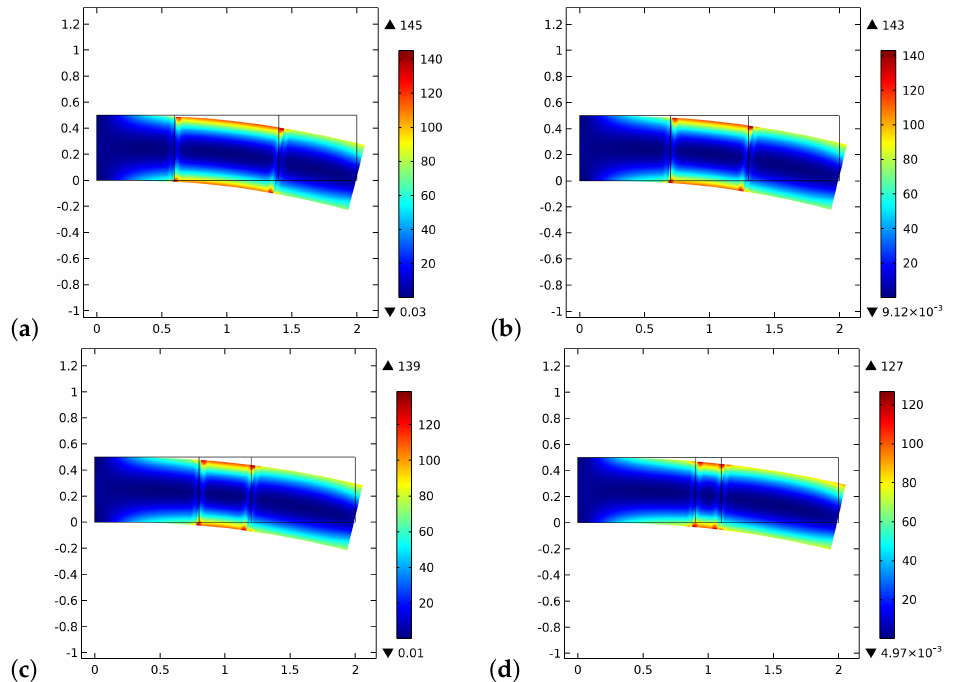
Figure 10. The distribution of the dissipated energy density at the beginning of the time of simulation for different substitute lengths of the graft: ( a ) 0.8 cm. ( b ) 0.6 cm. ( c ) 0.4 cm. ( d ) 0.2